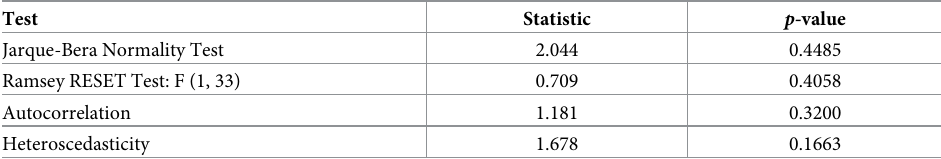
Table 8. Results of robustness tests.